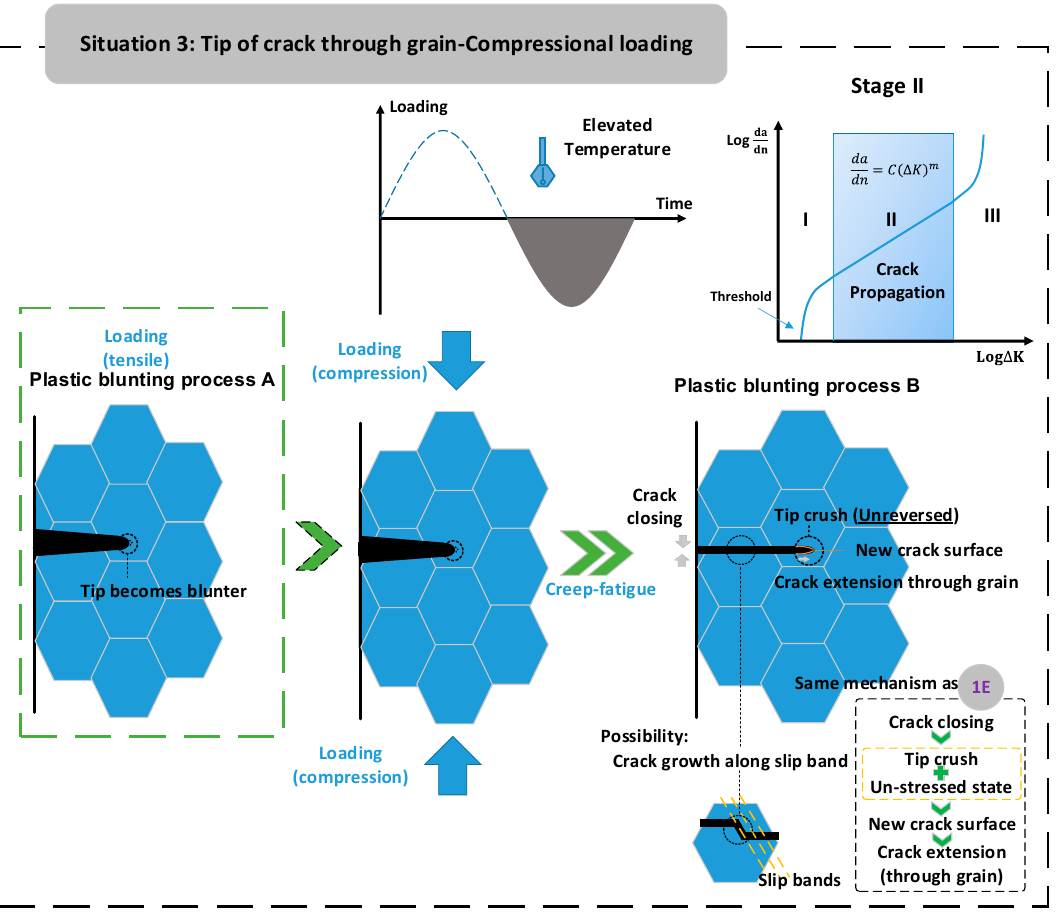
Figure 17. Crack tip through grain boundary—Compressional loading.